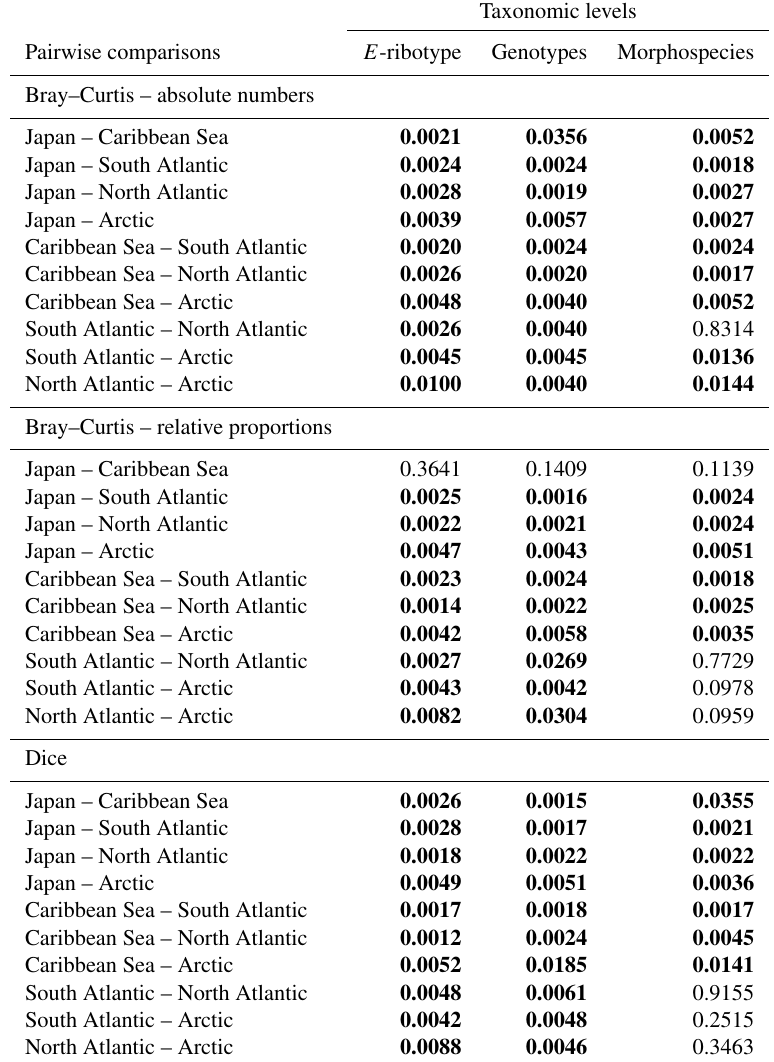
Table 1. Sequential Bonferoni significance p values of one-way PERMANOVA tests associated with NMDS (Fig. 4) for pairwise compar- isons of regions for each taxonomic resolution and indices. Significant values ( p <0.05) indicating that two regions have different distribution are shown in